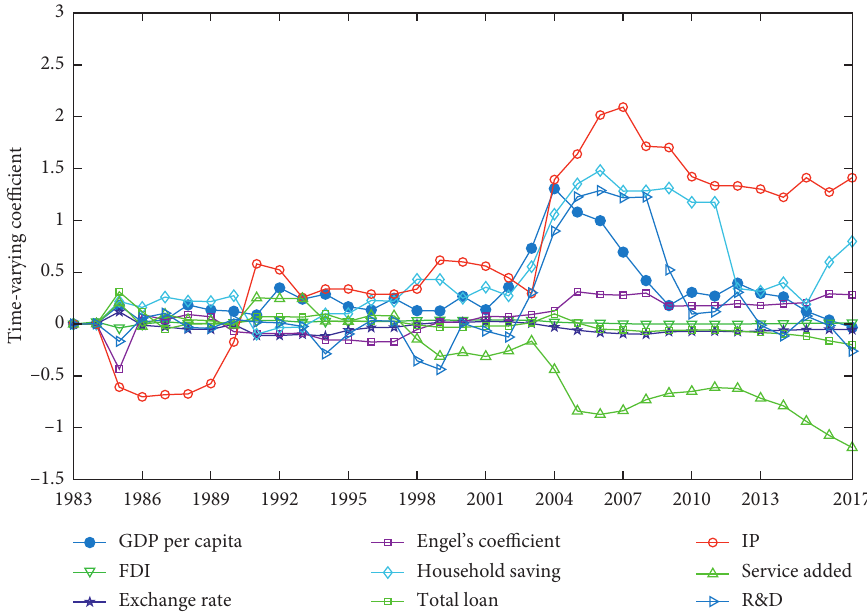
Figure 1: Estimations of time-varying coefficients of univariate TVP regression